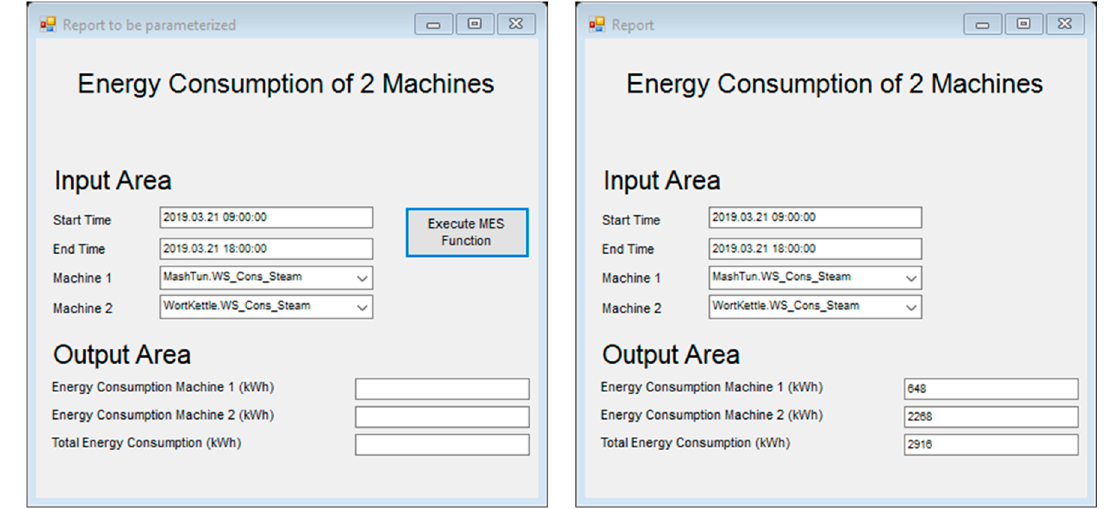
Figure 15. MES report with modified input area ( left ) and results in the output area ( right ).